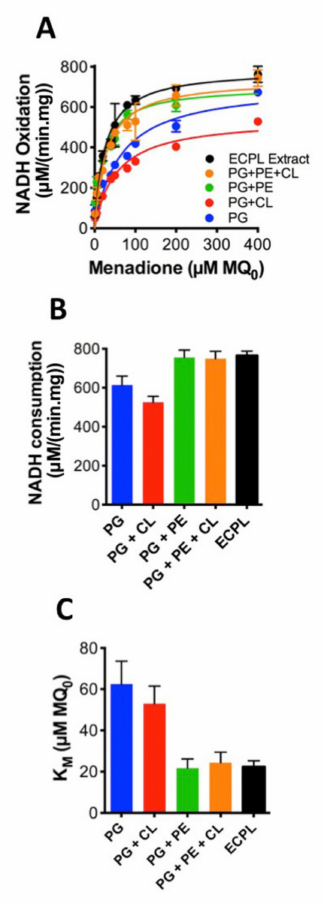
Figure 3. Influence of the lipid composition on efficient Cth NDH-2 catalysis using menadione as a soluble shuttle. Cth NDH-2 was reconstituted into vesicles composed of 1% menaquinone-7 (MQ 7 ) in one of the following lipid compositions: pure phosphatidylglycerol (PG; blue); PG + 10% cardiolipin ((CL) red); 33% PG + 67% phosphatidylethanolamine ((PE) green); 9.8% CL + 23.2% PG + 67% PE (orange); and E. coli polar lipid extraction (ECPL; black). Assays were performed in the presence of menadione as per the system shown in Figure 2B). ( A ), Kinetic curves of Cth NDH-2 activity in different lipid compositions; ( B ), V max values derived from the data in ( A ); ( C ) K M values derived from the data in A . Experiments were performed in triplicate and the error is